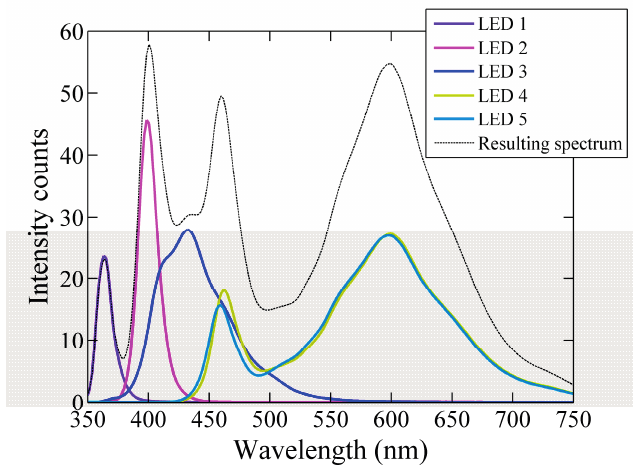
Figure 2. Individual light emission spectra of the 5 LEDs used by VIPER. The emission peak wavelengths, λ p , are 365 nm, 400 nm, 430 nm, 600 nm and 600 nm for the LED 1 to LED 5, respectively. The dashed line represents the final emission spectrum (combination of the 5